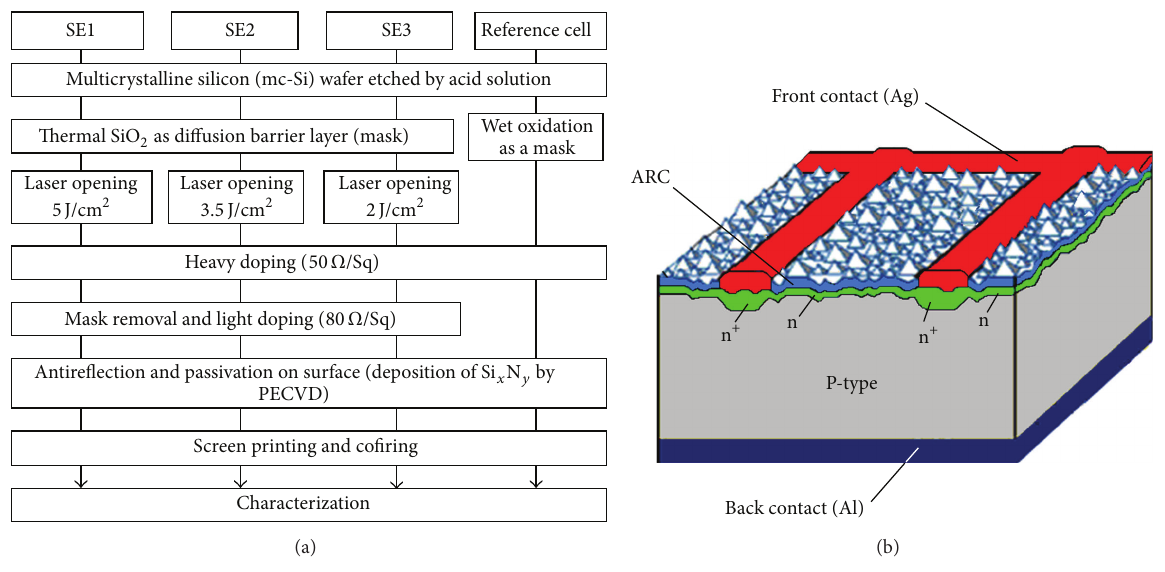
Figure 1: (a) Major processing sequence of SE solar cells utilized by laser opening technique. (b) The sketch of our developed solar cell